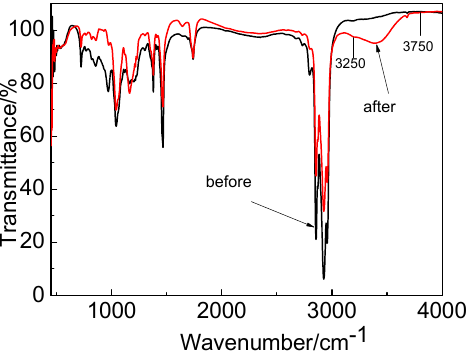
Figure 13. IR spectrogram before and after extraction by P507–N235 system. In a chlorine-containing system, the chloride ion can form the complex CoCl 42− with Co 2+ , as Co 2+ has empty orbits and Cl − has high charge density. N235 can react with HCl and CoCl 42− in the acidic system. The reaction is represented as Equations (9) and (10).